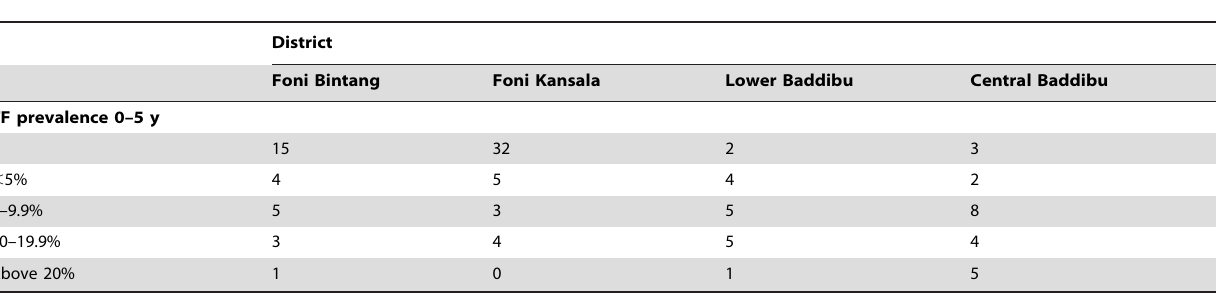
Table 5. Baseline TF prevalences in children 0–5 y in 115 villages by district.